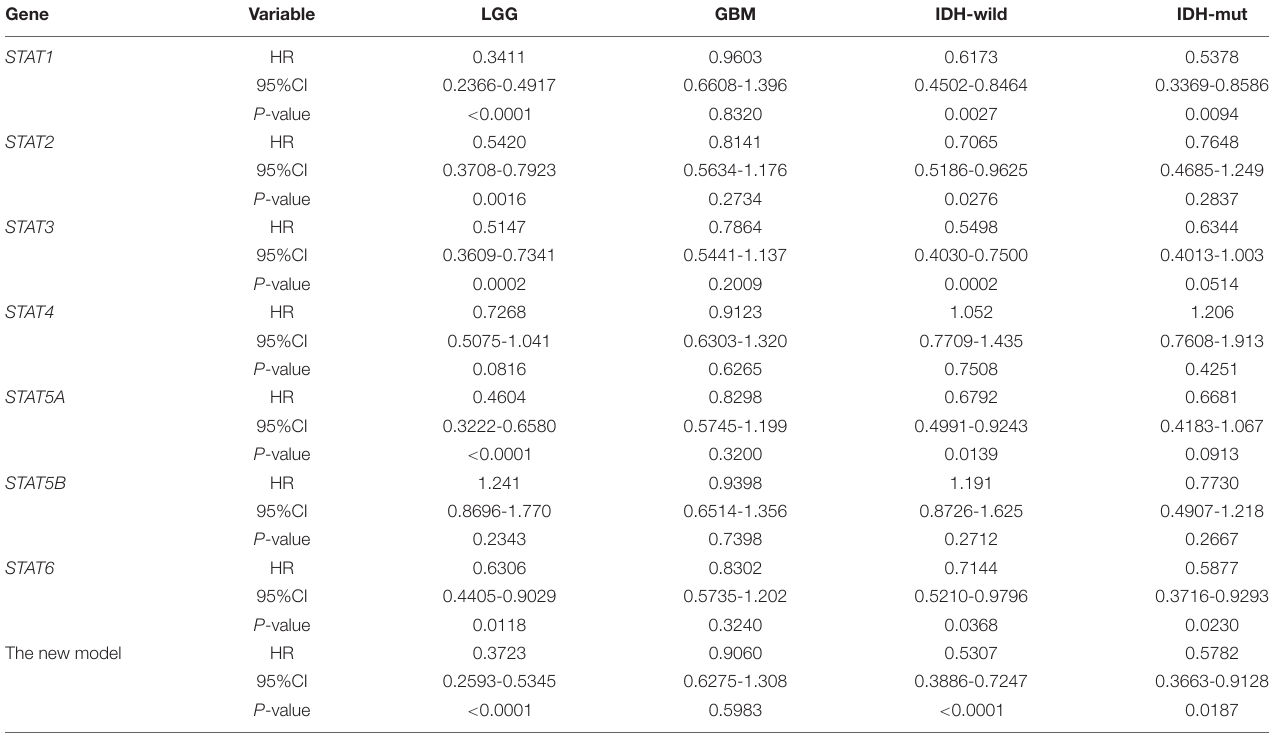
TABLE 2 | Subgroup analysis of the prognostic value of STATs in